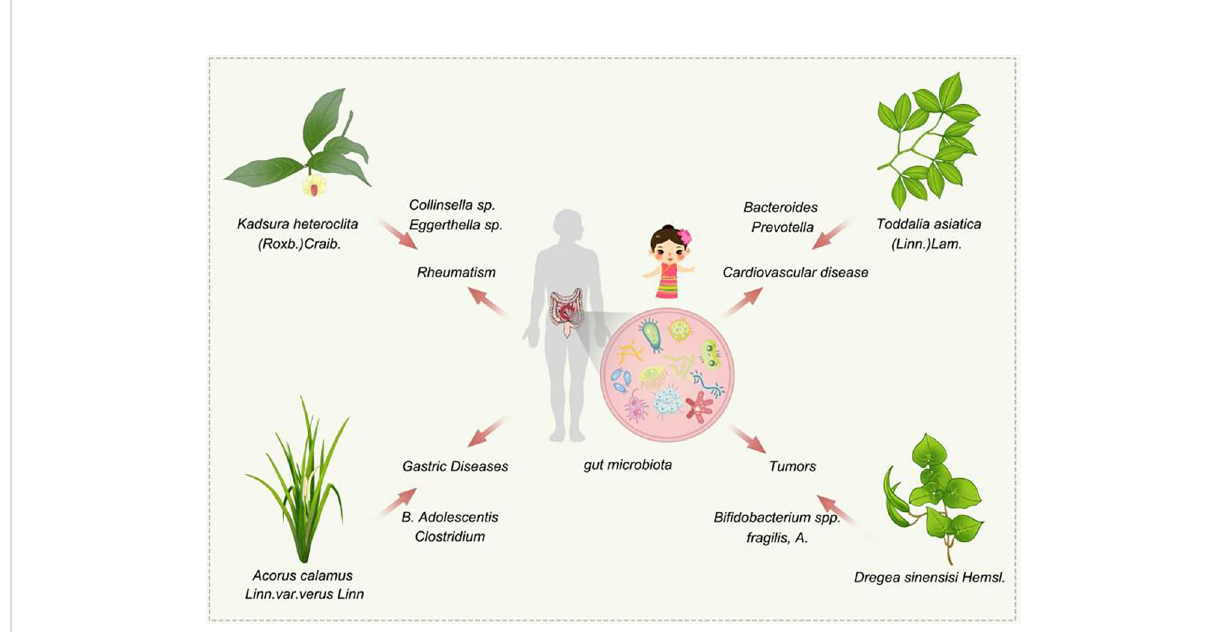
FIGURE 8 Schematic diagram of Dai medicine intervening in endemic diseases of Dai population through gut